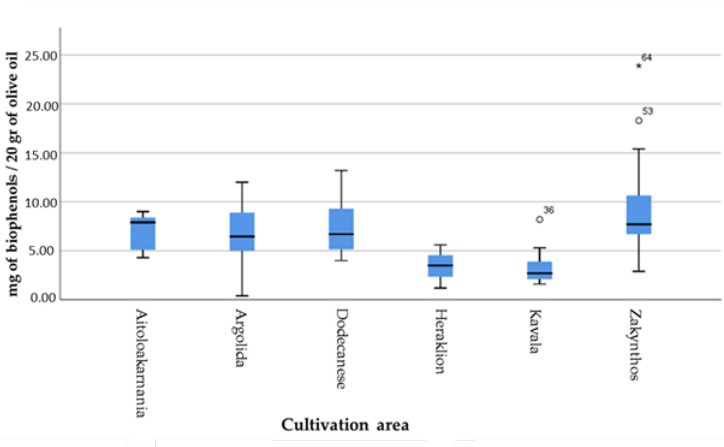
Figure 2. Comparison of biophenol concentrations with the area of olive cultivation.